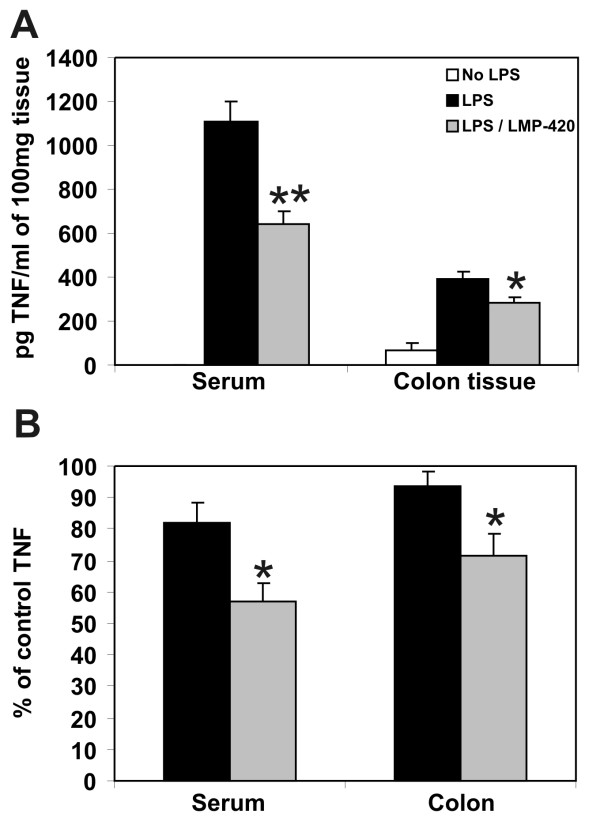
LMP-420 decreases serum and colonic TNF induced by LPS stimulation in vivo. A. Mice were pre-treated with 2 mg LMP-420 i.p. for 16 days. Four hours after the last injection, mice were challenged i.p. with a lethal dose of 0.5 mg LPS then euthanized 2 hrs. later for measurement of TNF levels in serum and in colon tissue lysates prepared at 100 mg tissue/ml. Serum TNF was below the limit of detection (< 10 pg/ml) in control mice not exposed to LPS challenge. *p < 0.05 and **p < 0.001 relative to control LPS-stimulated mice. B. In 2 separate experiments, groups of 5 mice were pretreated with 75 mg/kg LMP-420 given orally in food for 5 days prior to LPS challenge and TNF measurement. Data is presented as % of control value rather than as absolute numbers because mean serum TNF levels after LPS stimulation of control mice differed markedly (706 vs. 1870 pg/ml) in the 2 experiments. * indicates p < 0.05 compared with control.